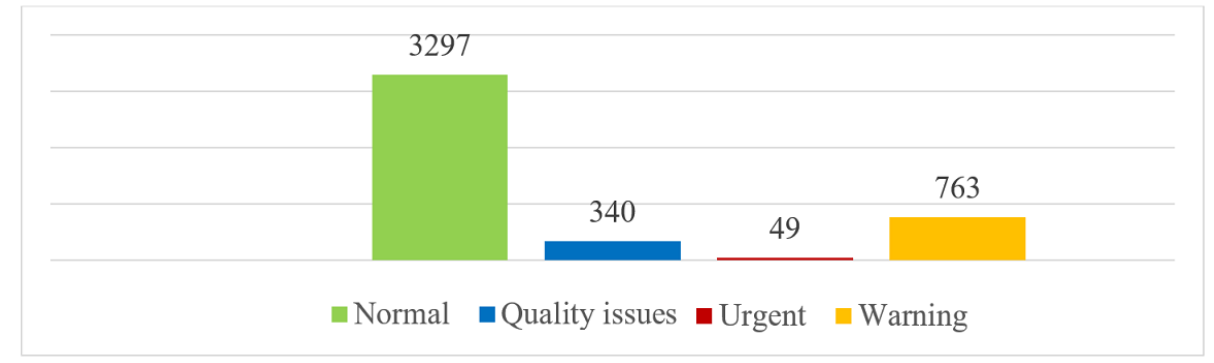
Figure 3. Number of different FibriCheck measurements (N=4449); 40 measurements were not validated by the algorithm due to connection